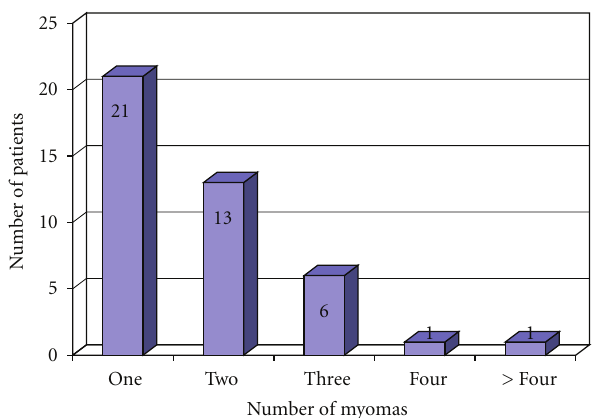
Figure 4: Number of pedunculated sub serous myomas ( n = 42) in laparoscopic